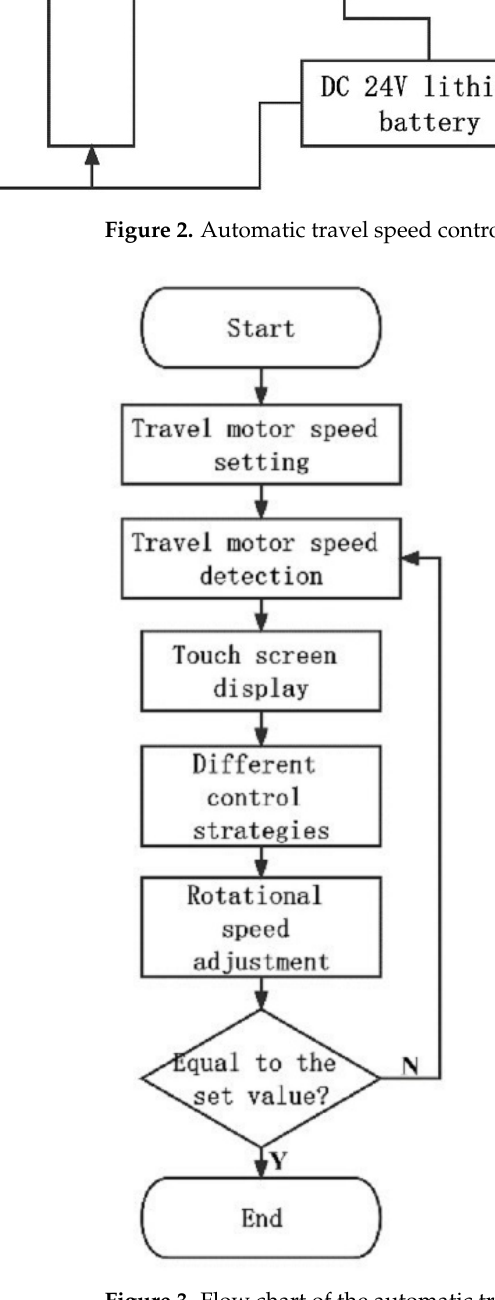
Figure 3. Flow chart of the automatic travel speed control program.